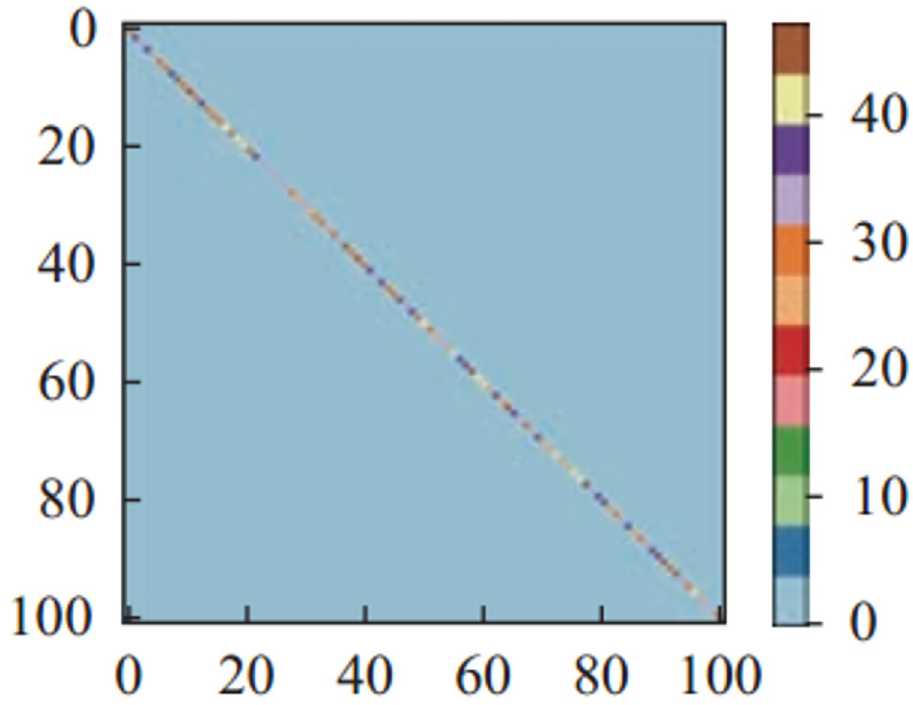
Fig 11. The confusion matrix of the first sectionalization in UCF-101 under the input warped & original image.